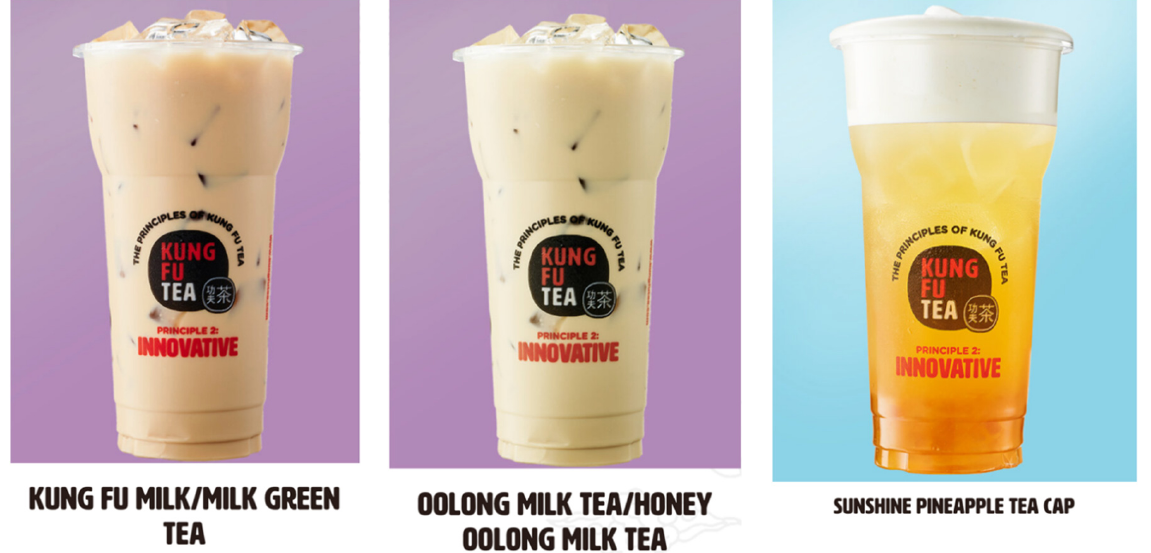
Figure 1. Examples of milk tea beverage menu in the realistic market.